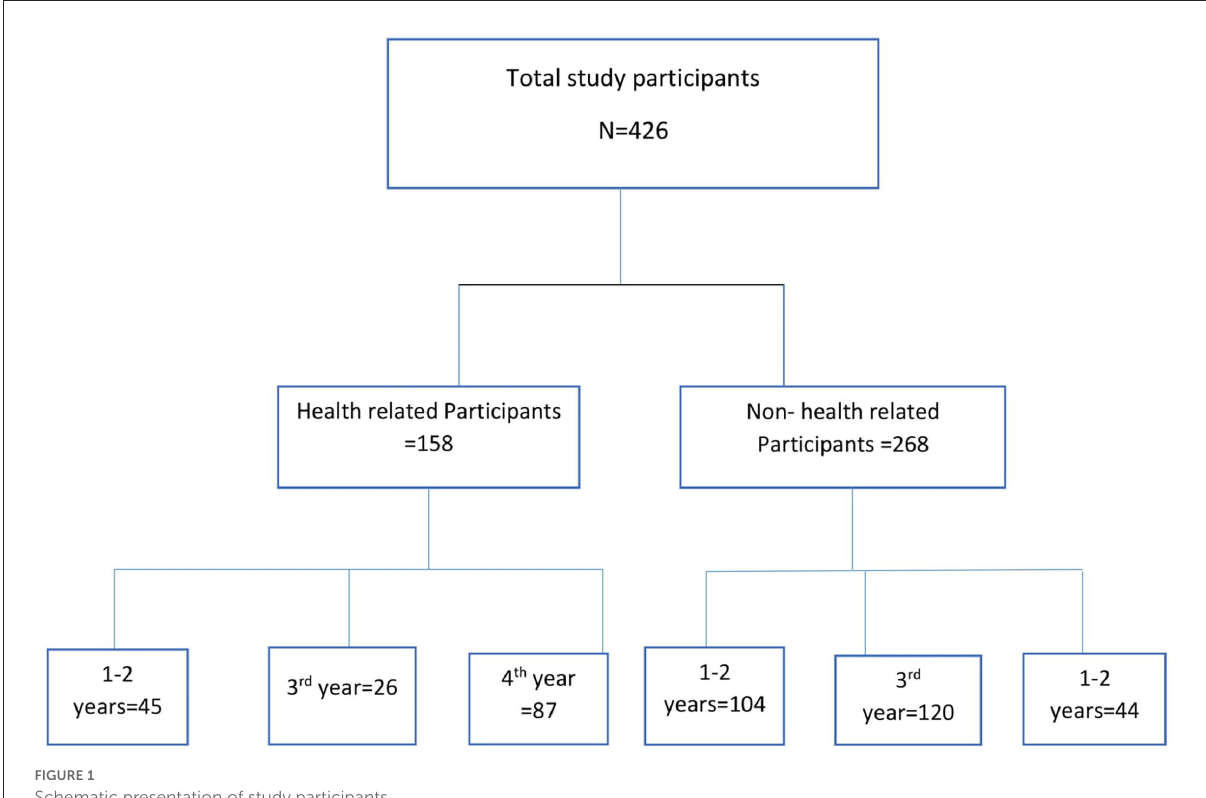
FIGURE1 Schematic presentation of study